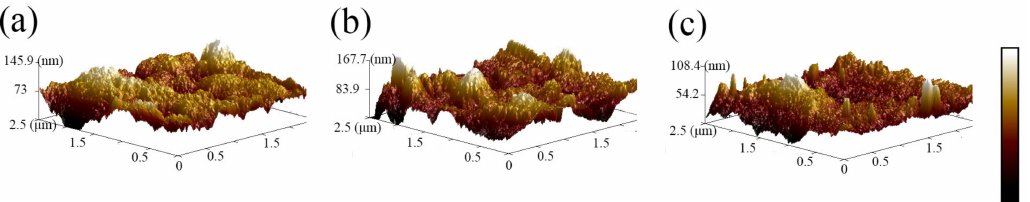
Figure 4. PhotographsofpurePVDFcomplexmembraneunderdaylight( a )and( b ),andUV light ( c ) and ( d ); SEM image of PVDF electrospinning membrane ( e ) Surface structure; ( f – h ) Cross-section structure.